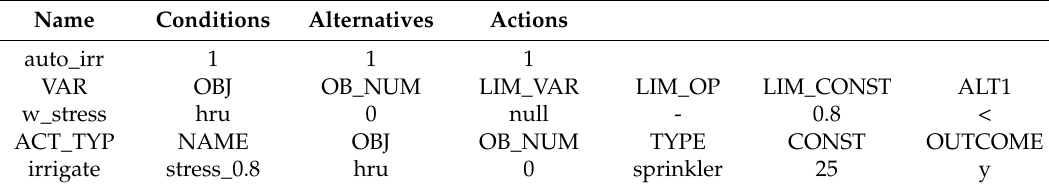
Table 5. Decision table for automated irrigation based on plant